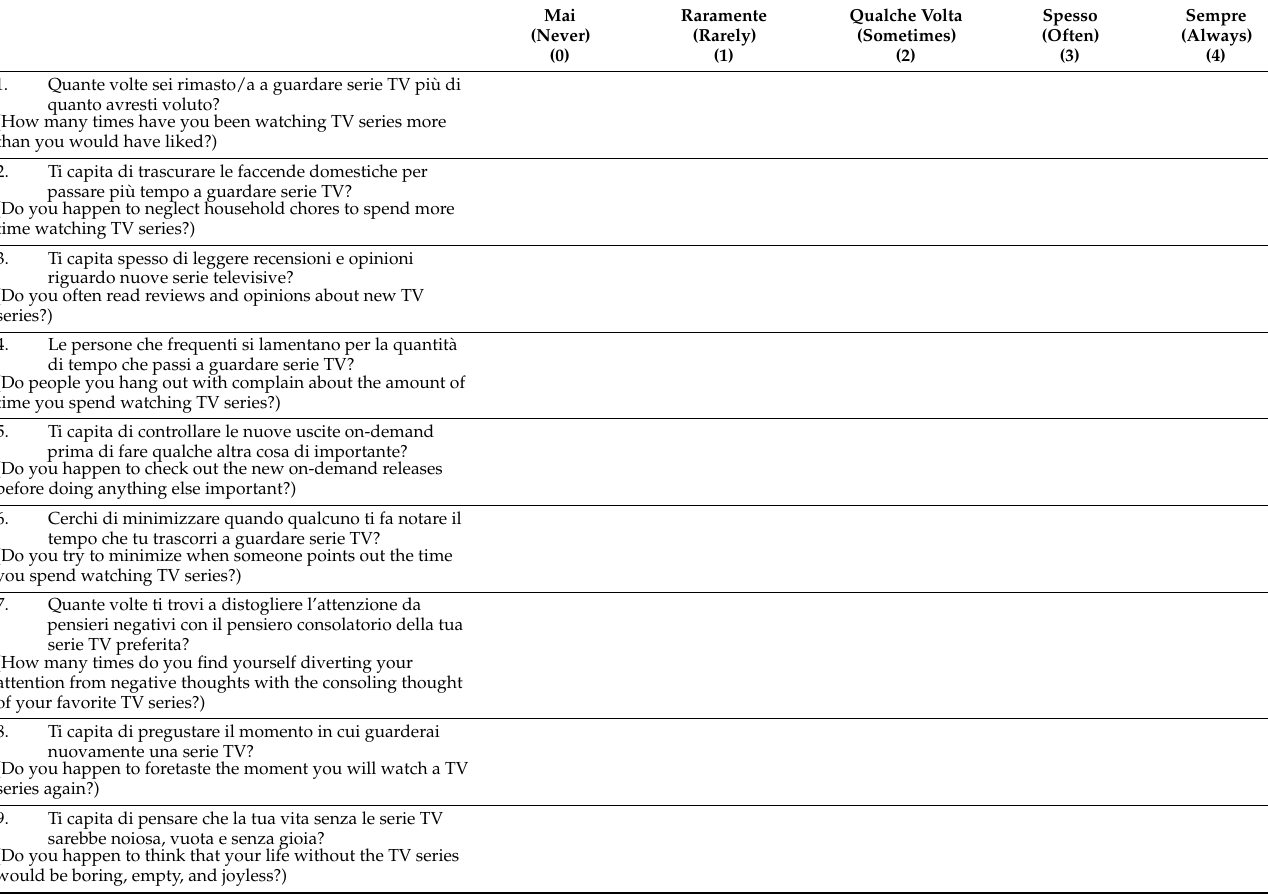
Table A1. Binge-Watching Addiction Questionnaire. The English translation is shown in